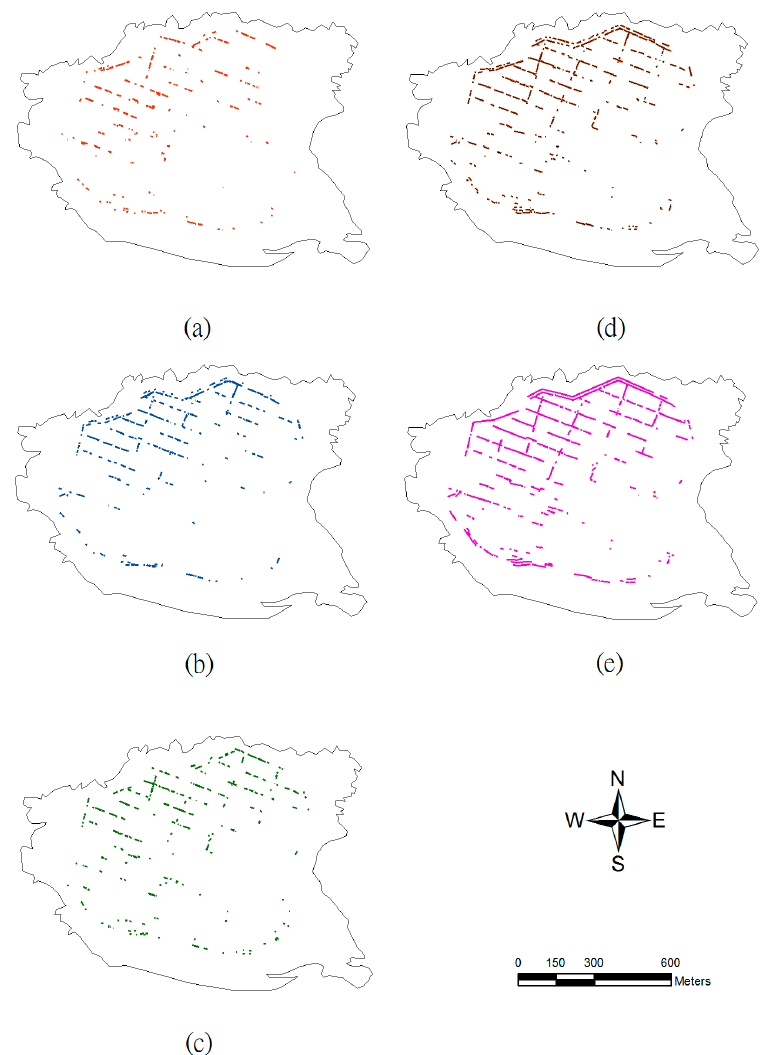
Figure 7. Line extraction from various topographic parameter maps with ( a ) slope, ( b ) maximum curvature, ( c ) openness, and ( d ) aggregation of line detection from the three topographic parameters, and ( e ) manual interpretation.